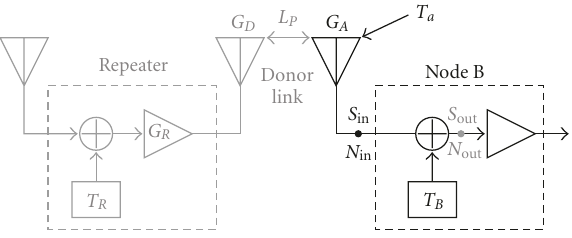
Figure 3: The e ff ective noise figure of the base station can be calculated taking the ratio of the SNR at the Node B antenna connector (repeater not installed) and the SNR at the Node B receiver